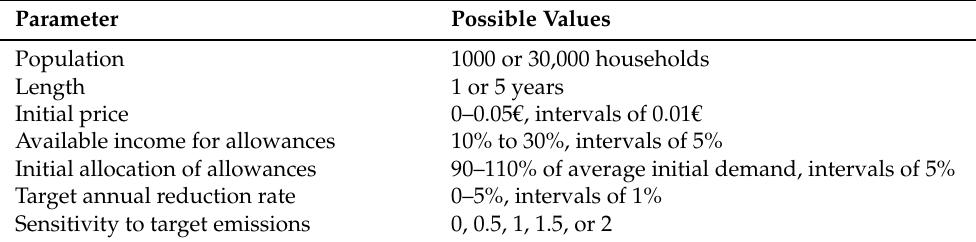
Table 1. Overview of model parameters and possible